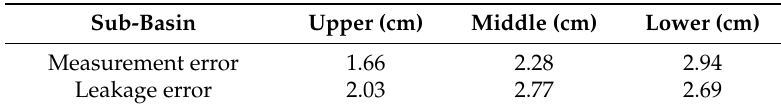
Figure 2. The Global Land Data Assimilation System (GLDAS) terrestrial water storage (TWS), filtered total terrestrial water storage (TTWS), and recovered TTWS time series in the ( a ) upper, ( b ) middle, and ( c ) lower sub-basins of the Yangtze River Basin (YRB). The green, blue, and red lines represent the GLDAS TWS, filtered TTWS, and recovered TTWS time series, respectively. The correlation coefficient (R) between the GLDAS TWS and recovered GRACE TTWS time series during the Three Gorges Dam (TGD) impoundment period are also shown. Table 1. Measurement and leakage errors of the total terrestrial water storage (TTWS) in the upper, middle and lower sub-basins of the